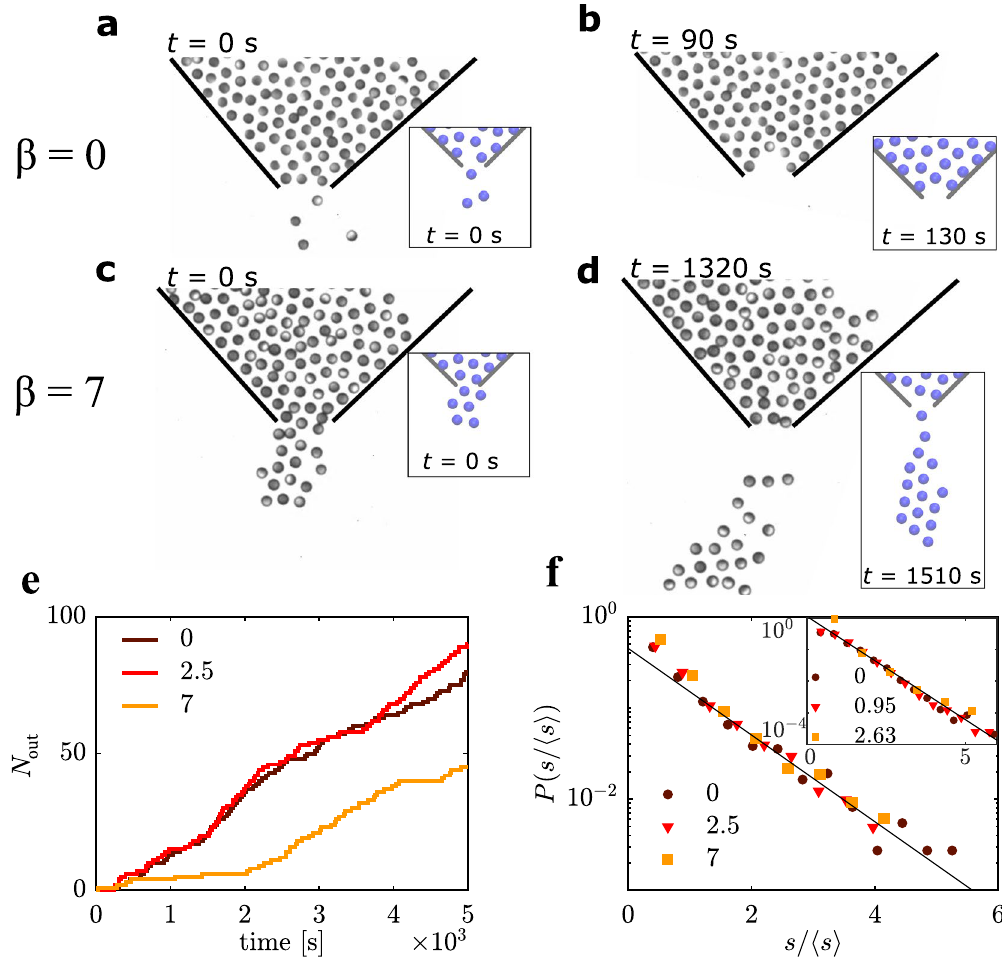
Figure 2. Clogging mechanisms. Snapshots of the bottleneck in the two different regimes: For β = 0 the particle flow ( a ) is interrupted by arches ( b ). For β = 7 , droplets ( c ) form and eventually detach ( d ). The insets show the correspondent situations as observed in numerical simulations at the same β/β 0 . The images of the inset were created using Visual Molecular Dynamics (VMD) 28 . ( e ) Exemplary curves of the cumulate number of particles having passed the obstacle. The colours refer to values of β . ( f ) Probability distribution function of burst sizes s normalised by the average burst size (cid:31) s (cid:30) for different values of β . Note the log-lin scale. The solid s / � s � line is a fit ∝ e − 1.1 · . The inset is the associated simulation data, where we find P ( s / � s � ) ∝ e − 1.5 · the calculation, we register the time points at which particles enter a registration-area of length d and width σ , directly located at the aperture. In all figures, it is θ = 90 ◦ and d = 2.3 σ